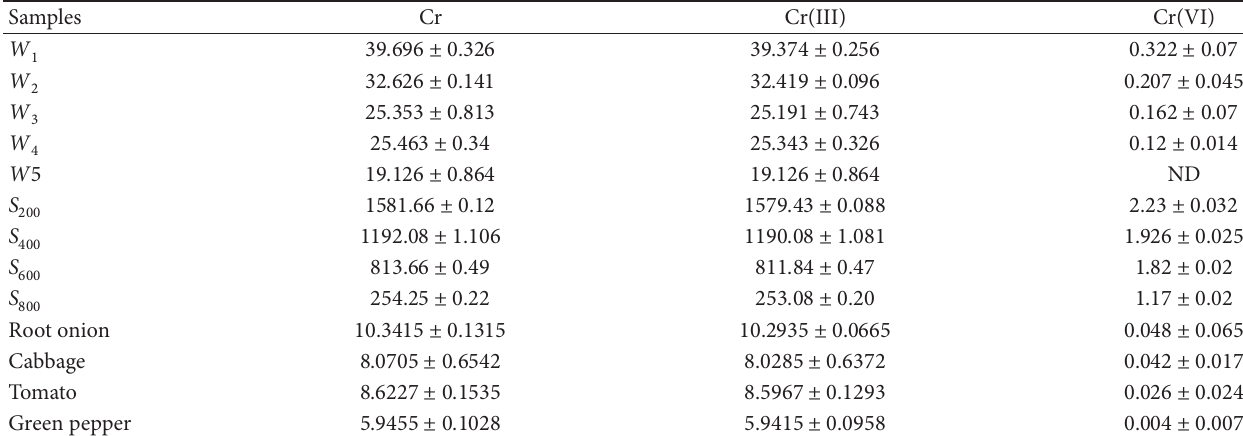
Table 1: Speciation of Cr(III) and Cr(VI) in water, agricultural soil, and vegetables (mg ⋅ Kg −1 ). Samples